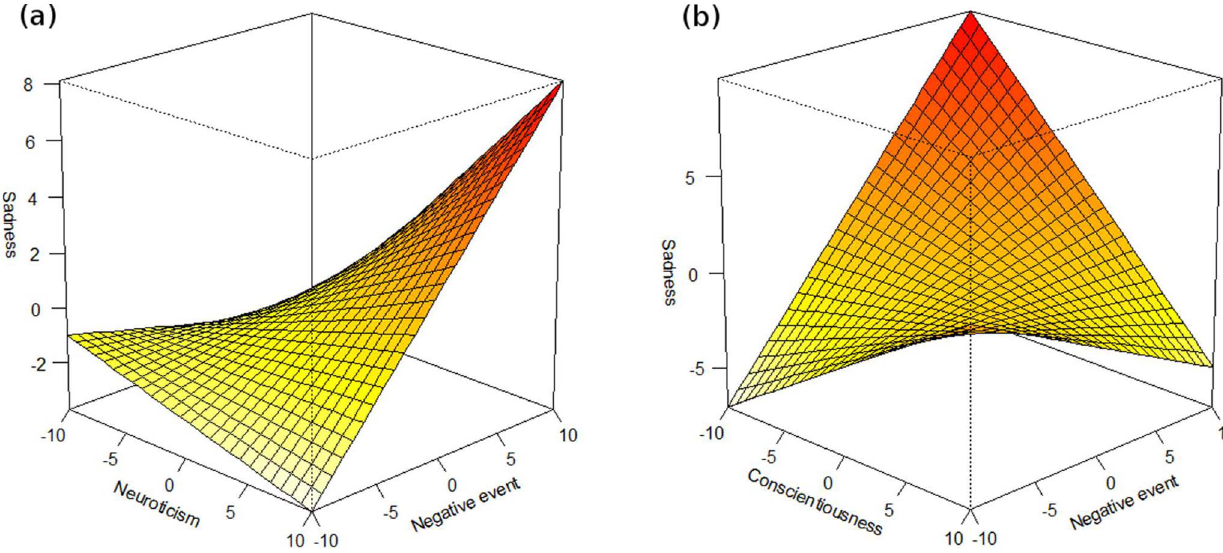
Figure 1. The association of (a) neuroticism and (b) conscientiousness with reactivity to daily negative events. The figure illustrates Hierarchical linear modeling with sadness as a dependent variable and (a) neuroticism or (b) conscientiousness and negatively evaluated daily event as well as their interaction as a predictor.